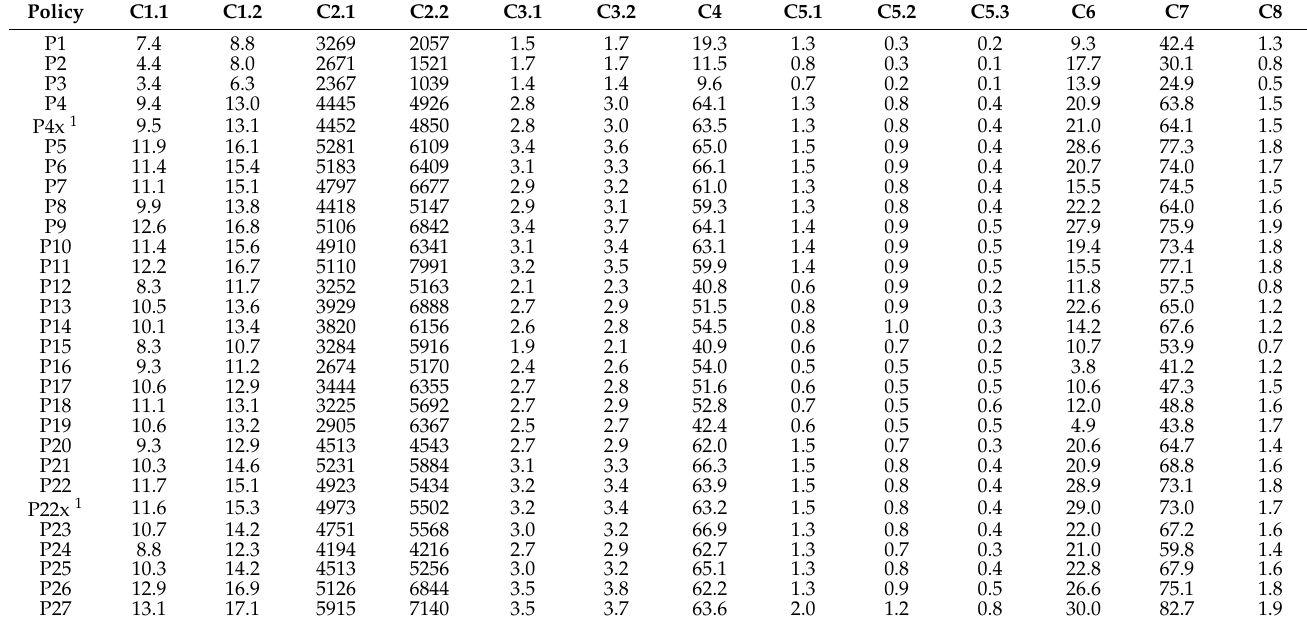
Table A5. Results—standard deviations of criteria values computed for all the alternatives assigned to a given